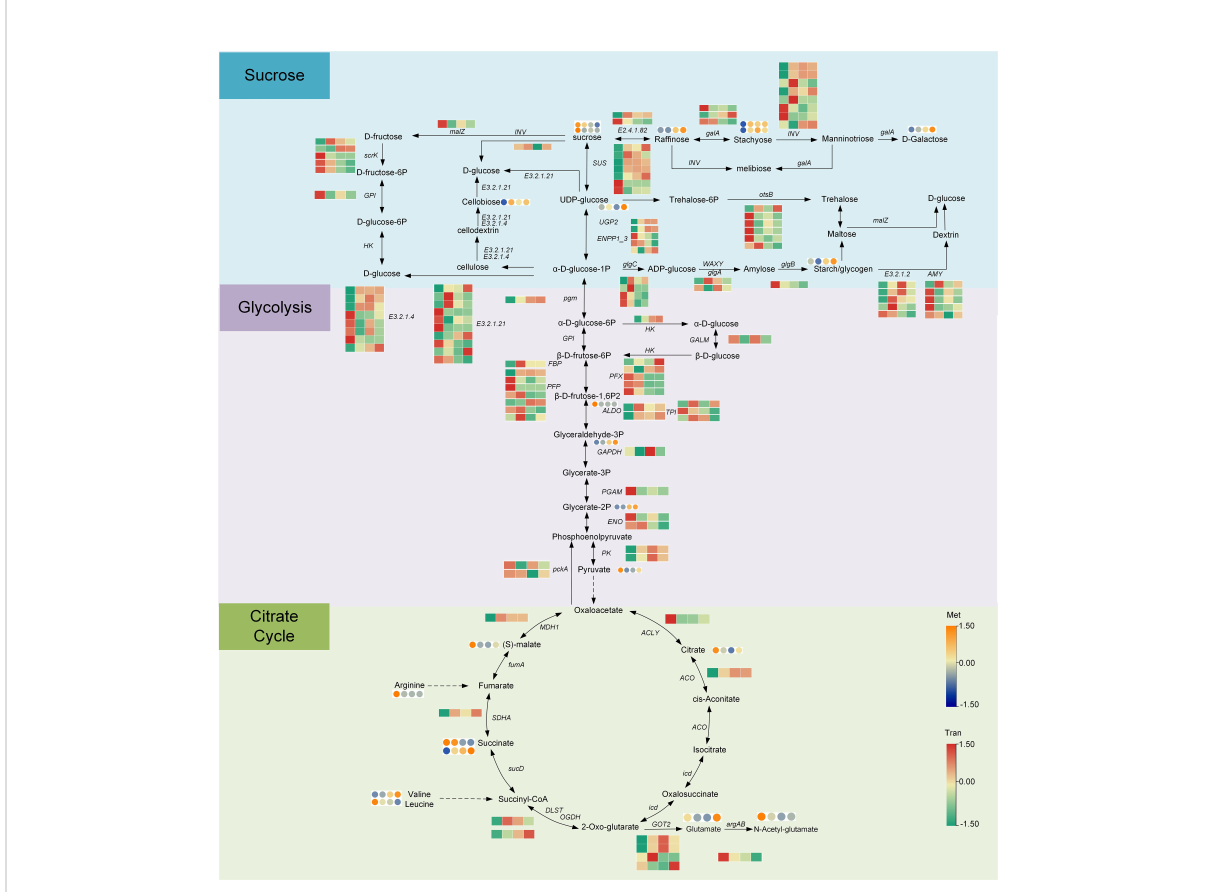
FIGURE 6 Analysis of genes and metabolites expressed in the sugar and acid biosynthesis pathways during lettuce fl eshy stem expansion stages (S1, S2, S3, and S4). The red (up-regulated) and green (down-regulated) in the heatmap represent gene expression, and the yellow (up-regulated) and blue (down-regulated) in the heatmap represent the expression of metabolites. The expression level was calculated using